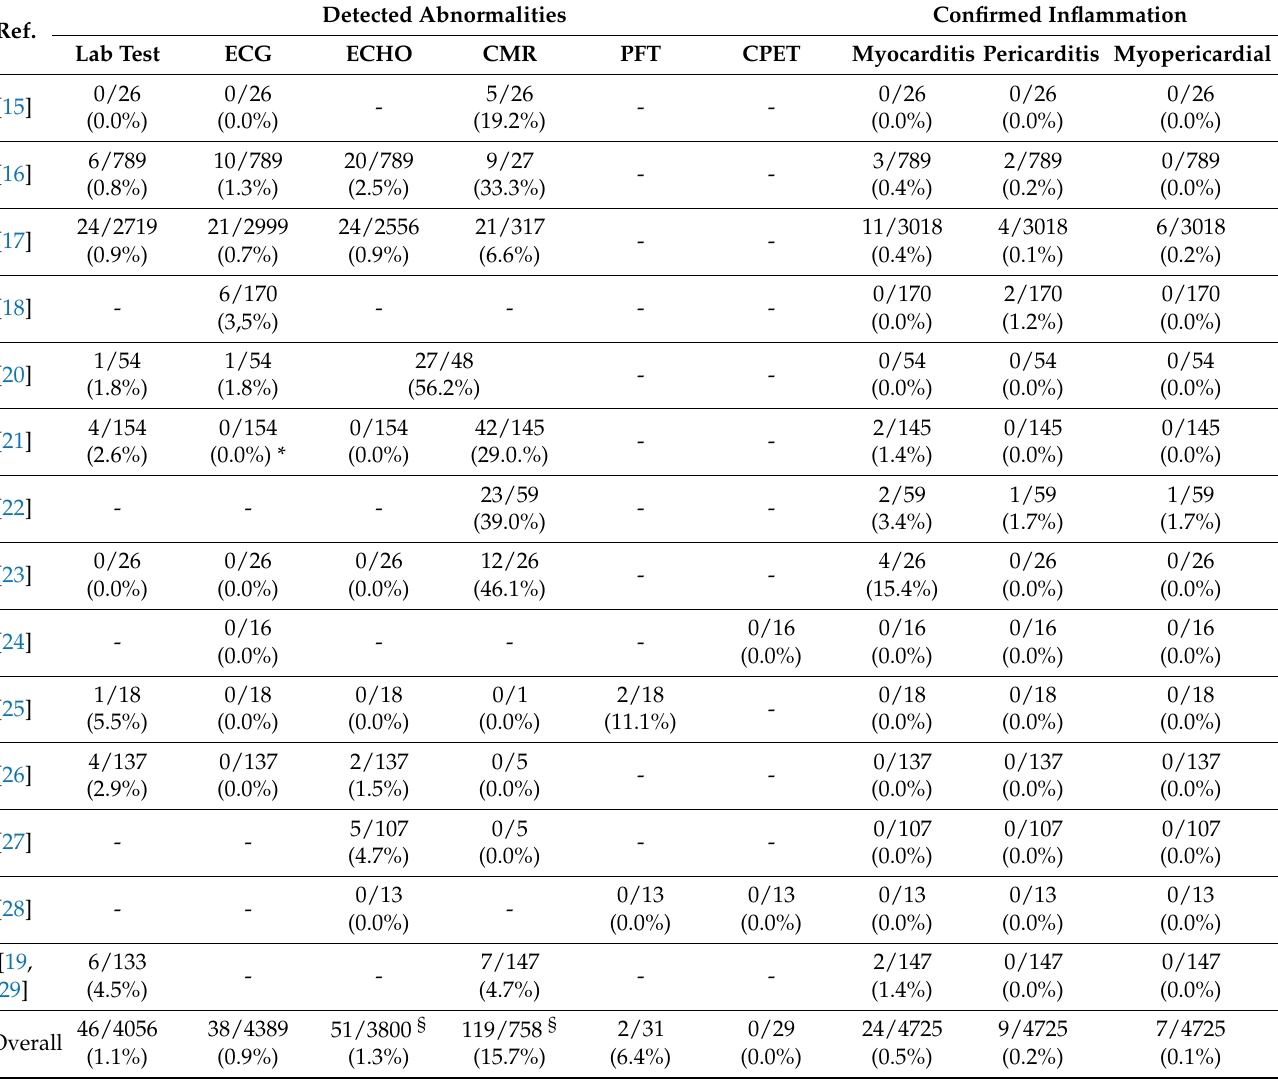
Table 2. Occurrence of cardiorespiratory abnormalities expressed as number of detected abnormalities over the total number of screening tests, and number of confirmed cardiac inflammation over the total